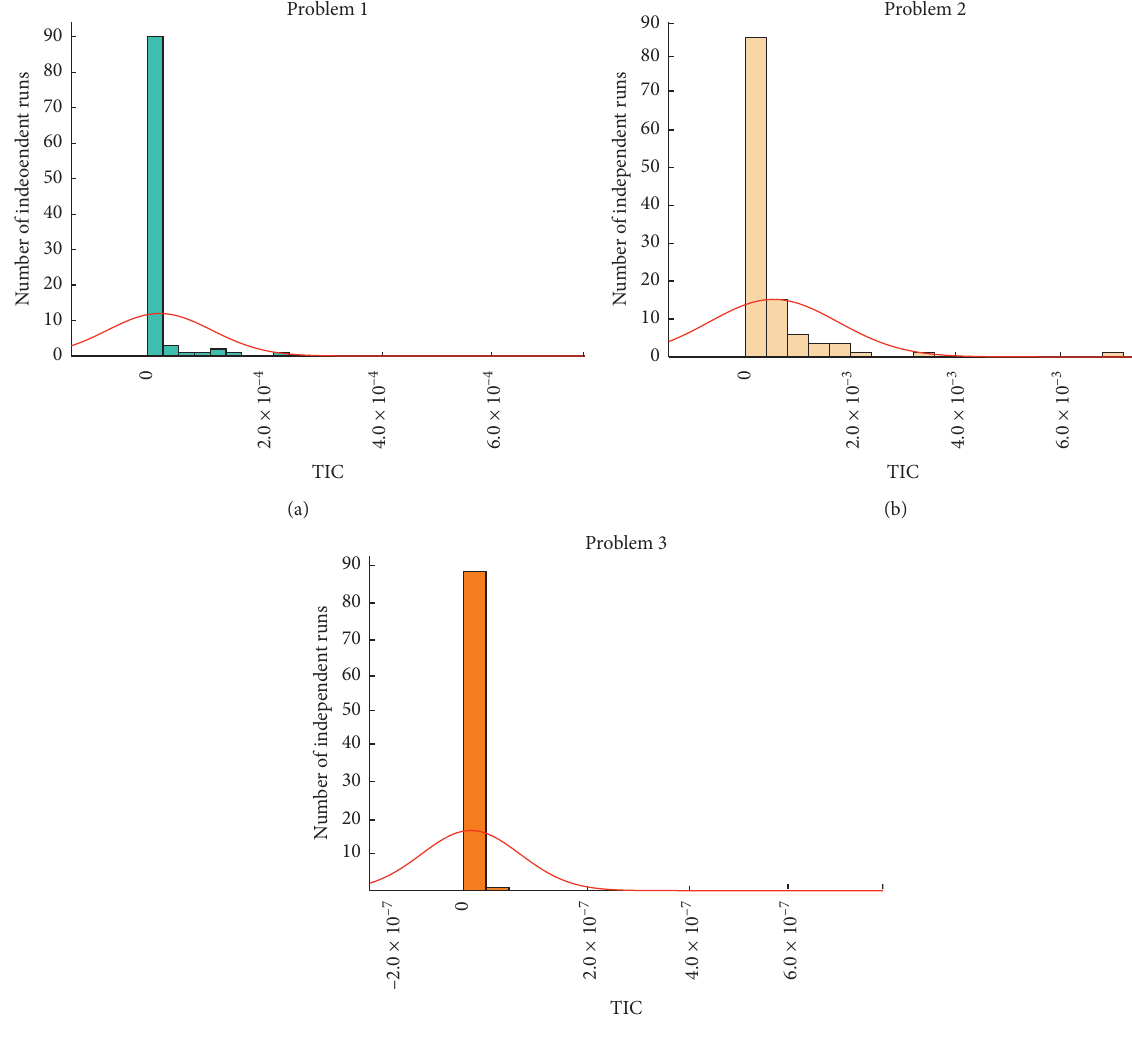
Figure 9: Normal probability plots of TIC obtained during 100 experiments for Problem